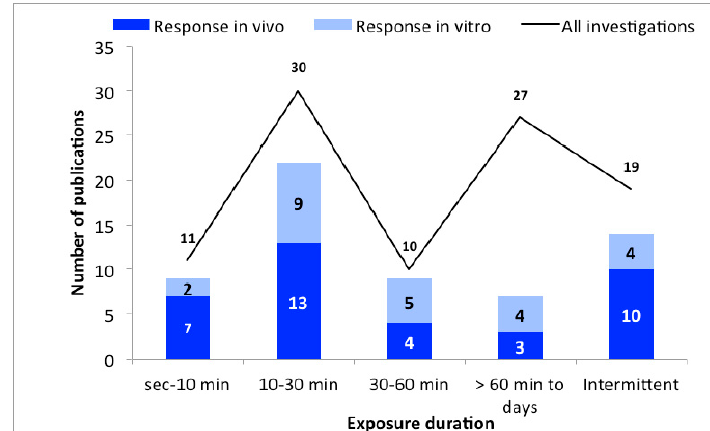
Figure 3. The number of publications as a function of exposure duration. The black line represent the total number of publications, and bars represent the in vivo (dark blue) and in vitro (light blue) studies with biological responses.